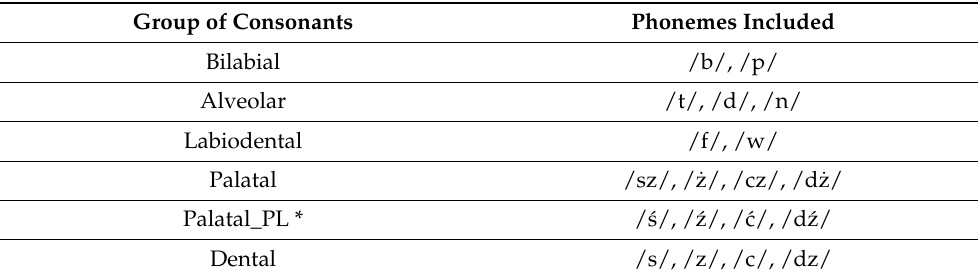
Table 2. Investigated phonemes were combined into groups according to their place of articulation in Polish.